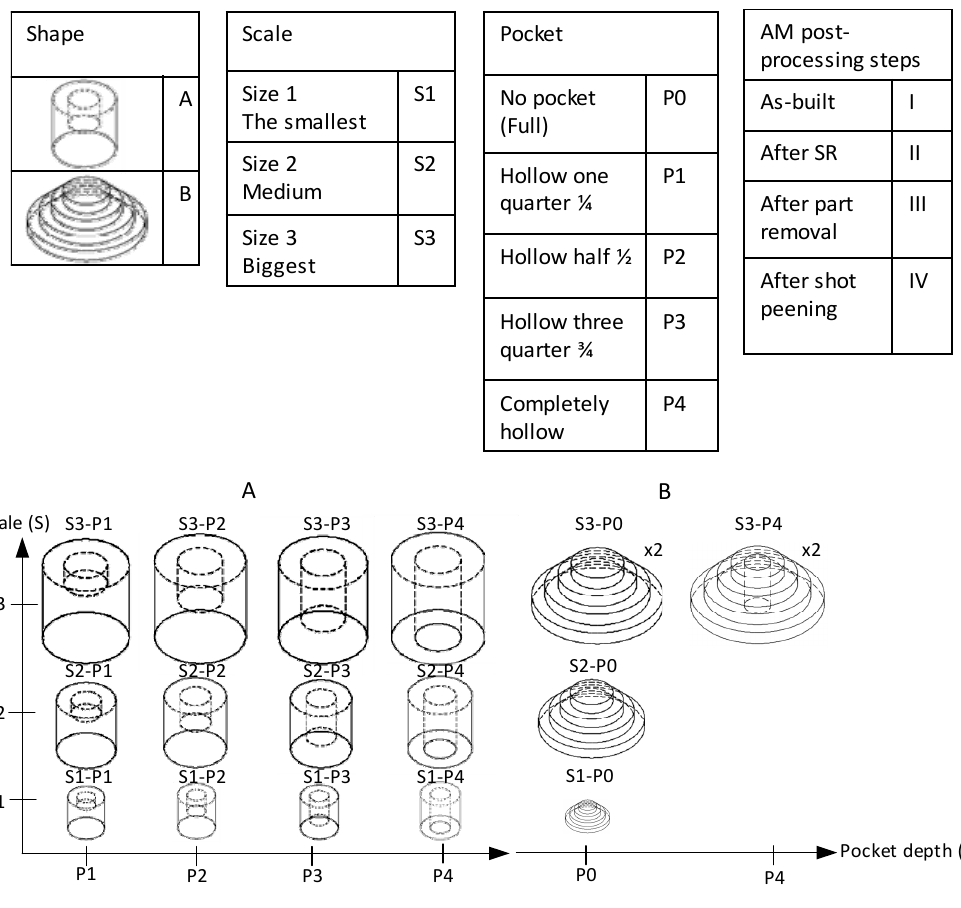
Figure 1. Variants of test artifacts .